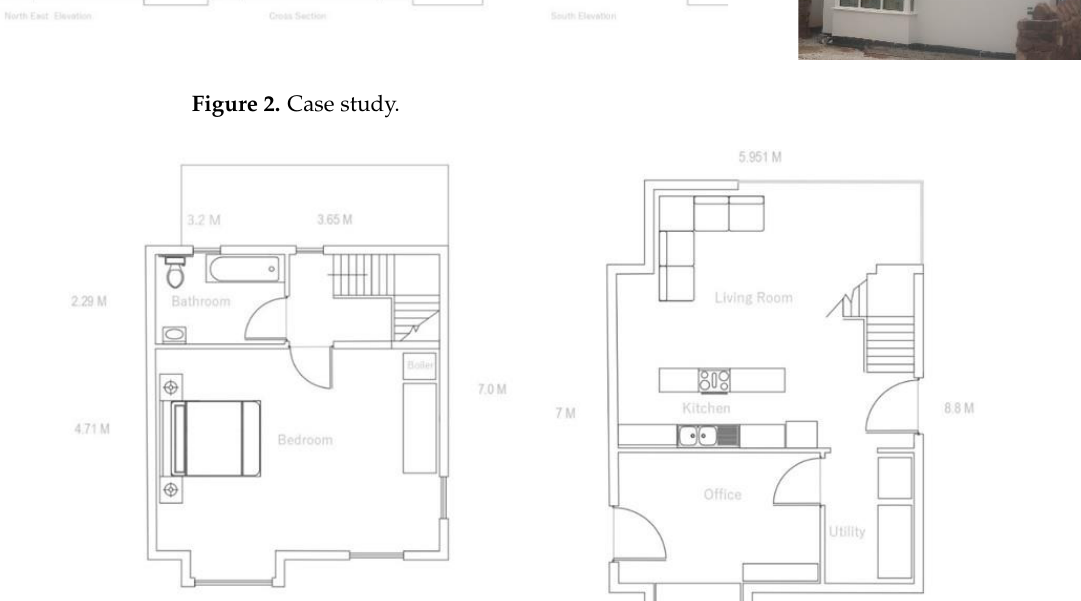
Figure 3. Ground and first floor plans.